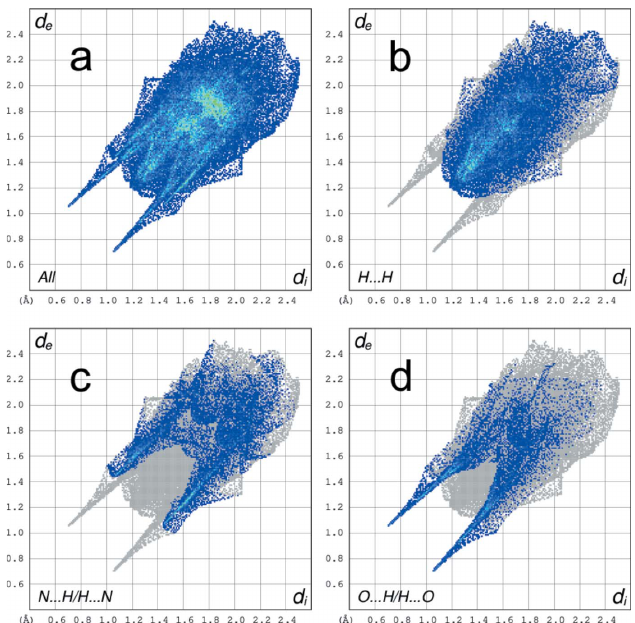
Figure 5 Overlay between the molecule obtained from experimental (orange) and DFT optimization